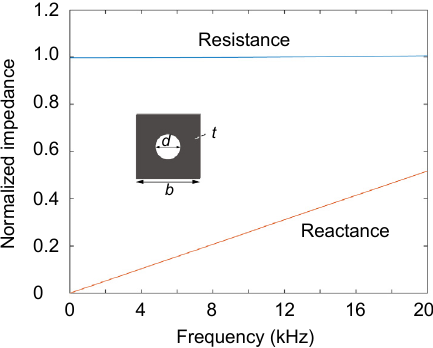
Fig. 3 | Normalized impedance of micro-perforated plate . d =38.5 μ m, b = t =100 μ m.